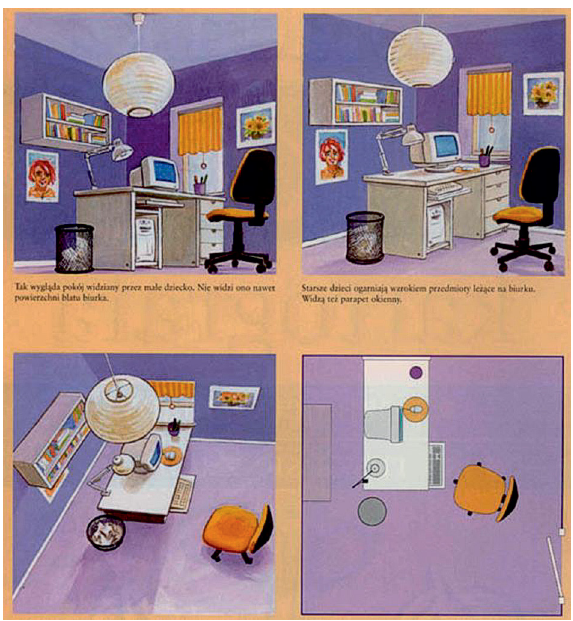
Fig. 1. The transition from the normal view to the projection